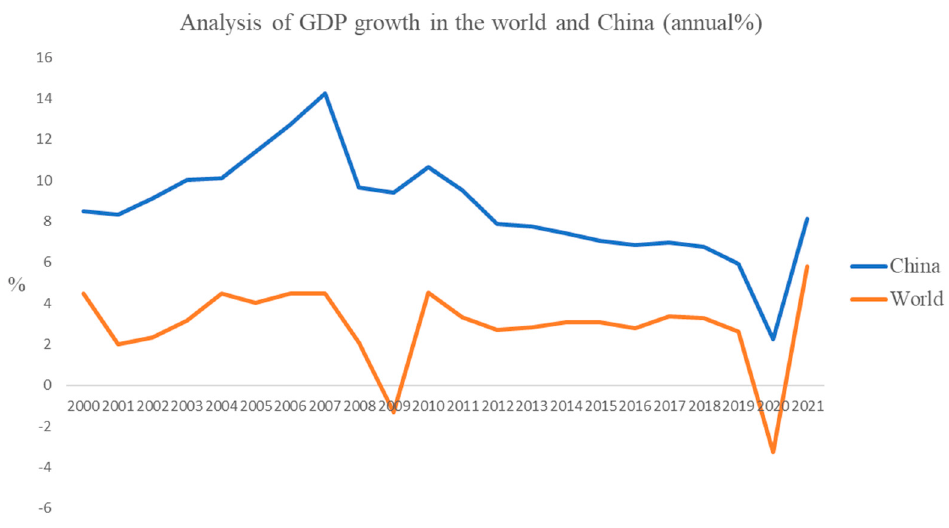
Figure 1. Analysis of GDP growth in the world and China (annual%).